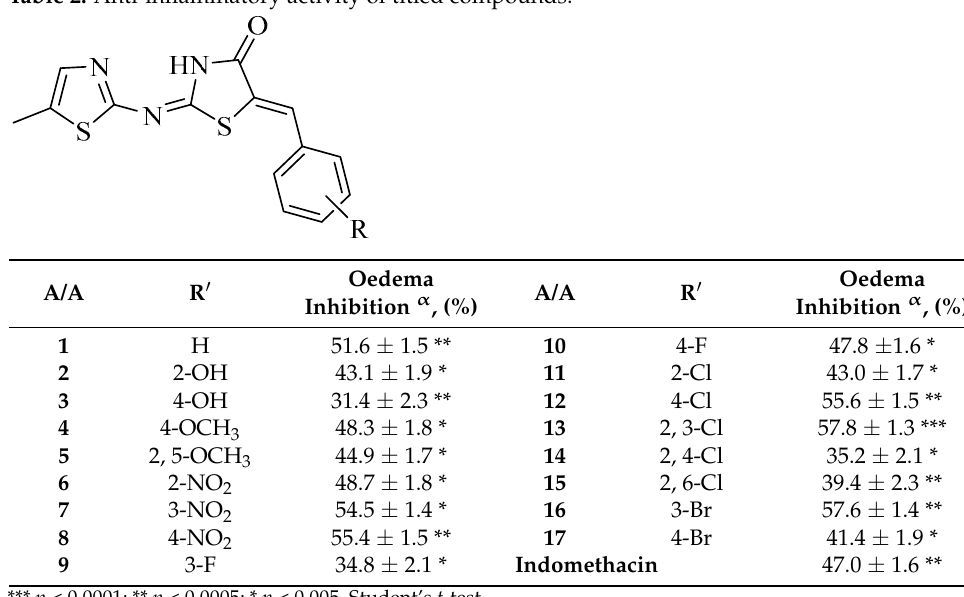
Table 2. Anti-inflammatory activity of titled compounds.